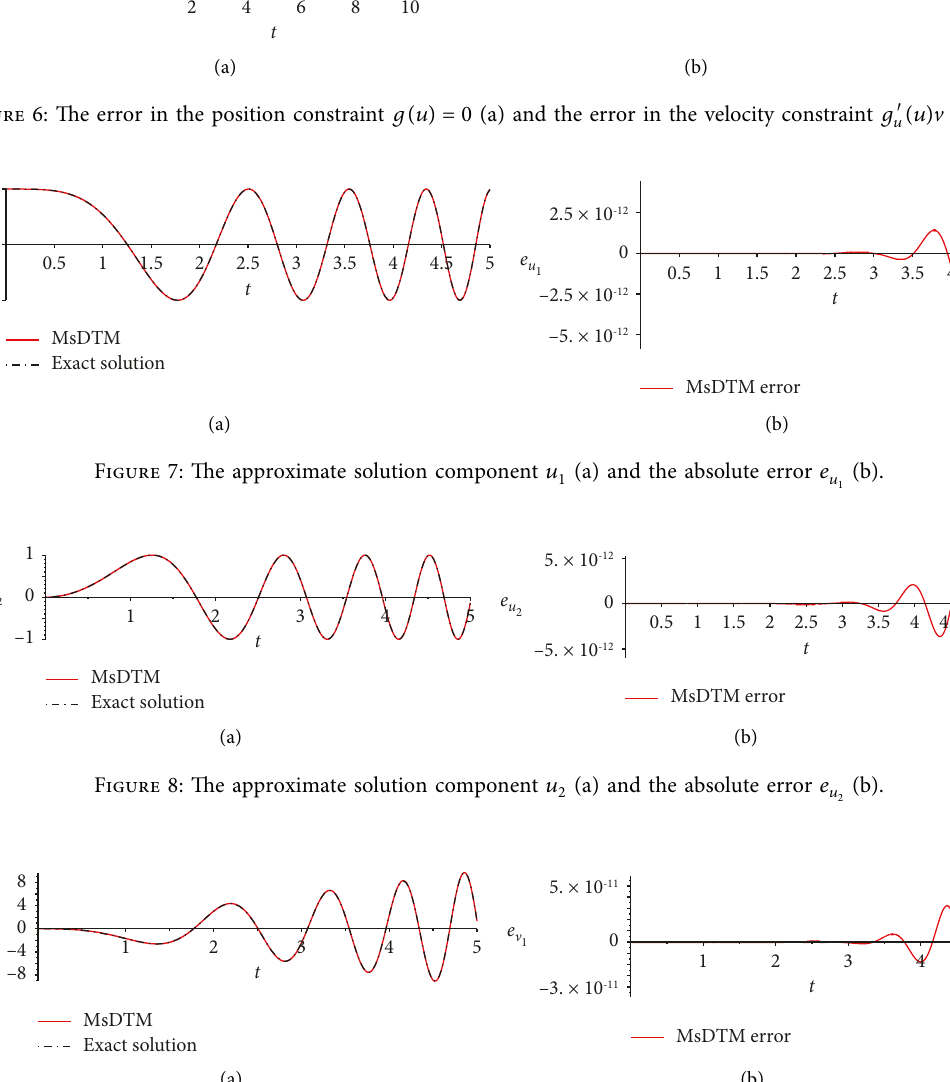
Figure 9: The approximate solution component v